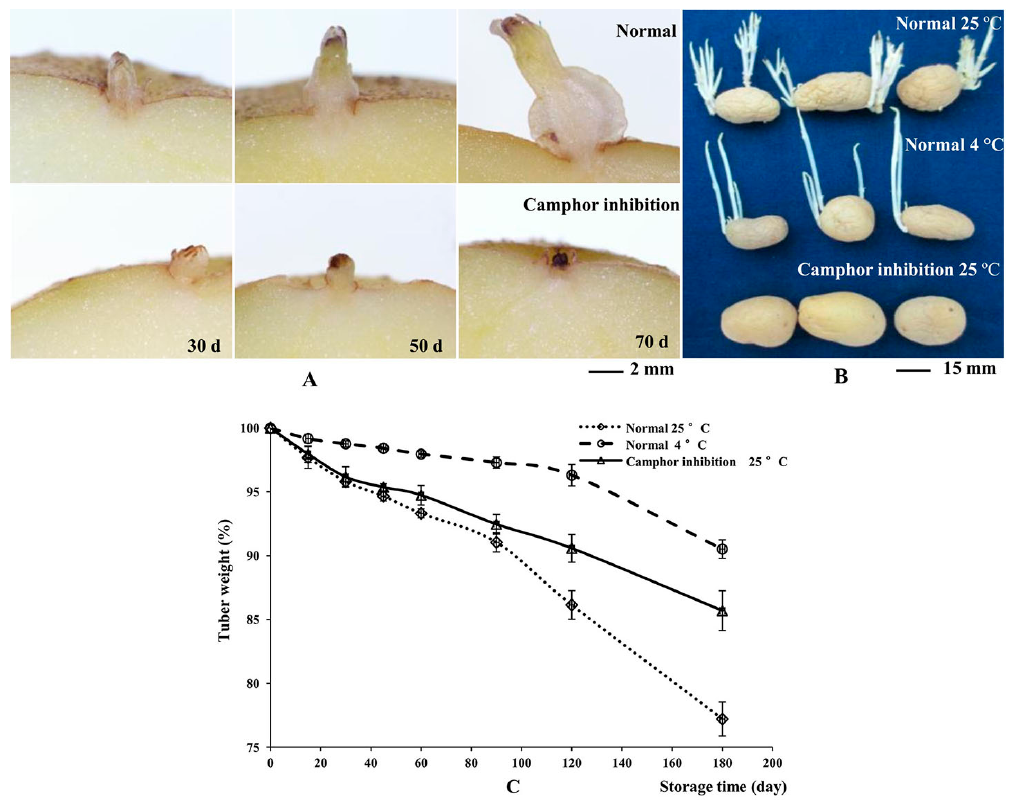
Figure 1. The effects of camphor inhibition on sprouting and tuber weight during storage. ( A ) Contrast of tuber sprouting between normal and camphor inhibition; ( B ) Morphological comparison of tubers stored under different conditions at 180 d; ( C ) Tuber weight loss during storage.